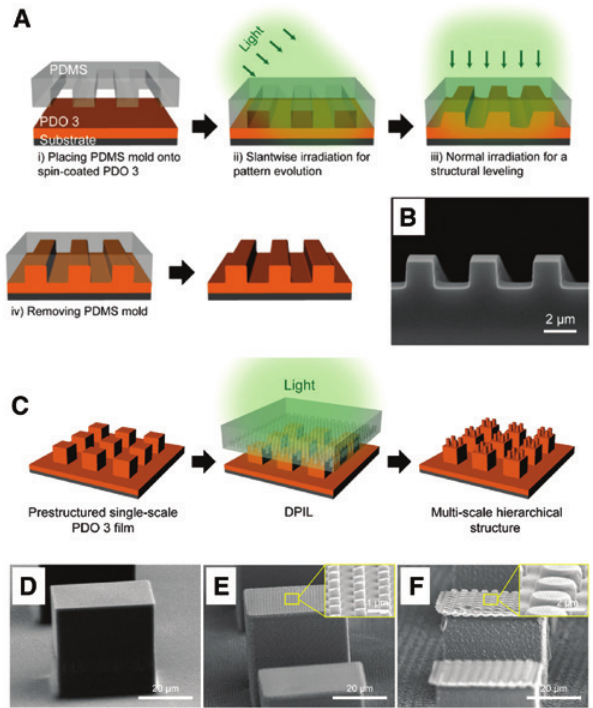
Figure 17: Fabrication of the prestructured azopolymer surfaces by means of the proximity field nanopatterning technique. (A) Schematic representation of the illumination configuration of a flat azopolymer film through the transparent structured PDMS stamp placed in tight contact with the azopolymer surface during irradiation. This all-optical patterning method is able to produce high-quality 3D microstructures (B) and even complex hierarchical textures (C–F). Adapted with permission from Ref. [269],